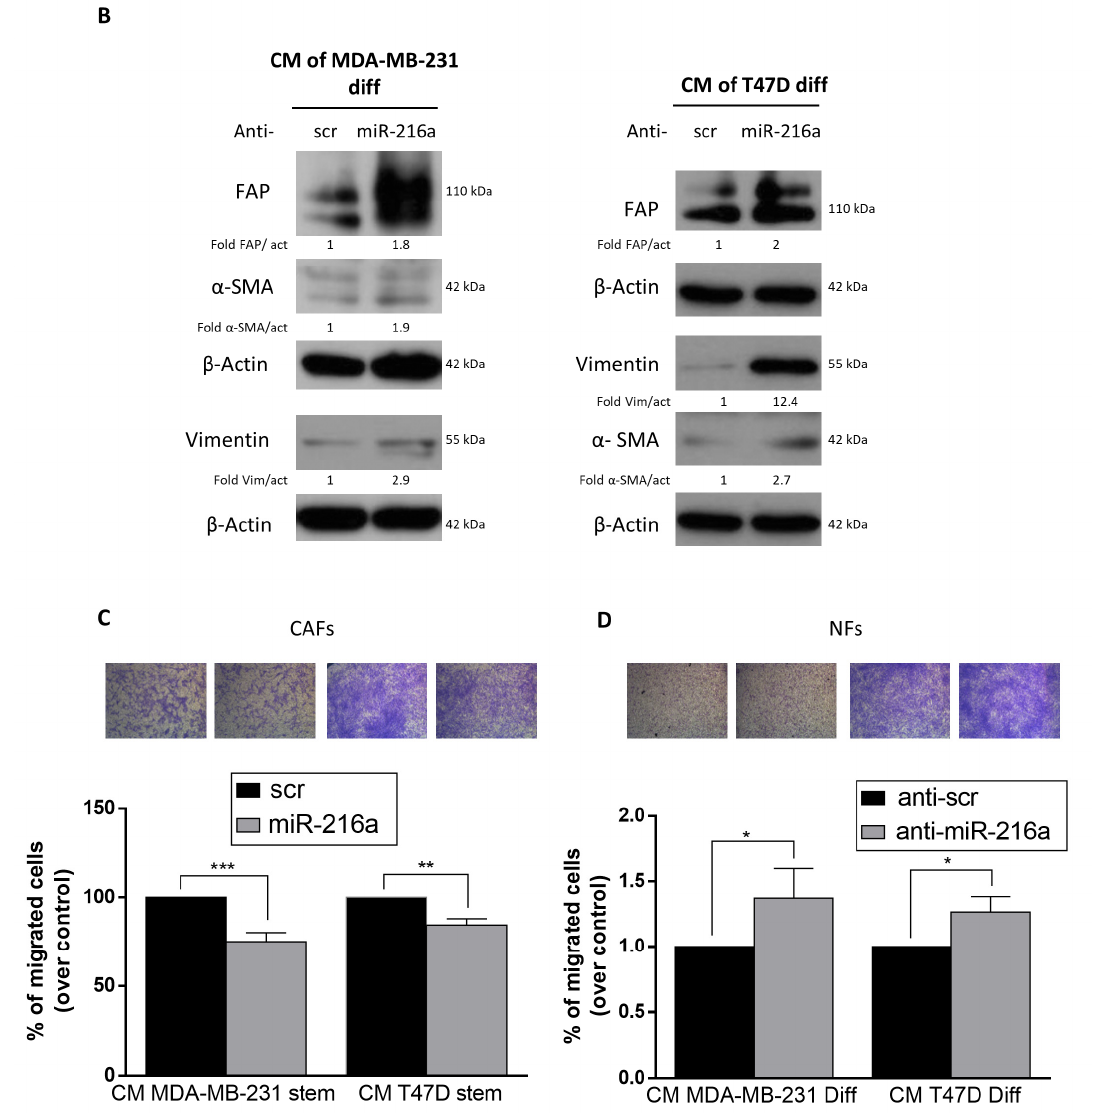
Figure 5. E ff ect of MiR-216a on cancer-associated fibroblasts (CAFs) and normal fibroblasts (NFs). ( A ) CAFs were treated with conditioned media collected from MDA-MB-231 and T47D stem cells overexpressing miR-216a. MiR-216a reduces CAF activation compared to the negative control. ( B ) Di ff erentiated MDA-MB-231 and T47D cells transfected with anti-miR-216a upregulates CAF markers in NFs. ( C ) CAFs treated with conditioned media collected from MDA-MB-231 and T47D stem cells transfected with miR-216a. MiR-216a impaired fibroblast migration compared to the negative control. Images were taken at 5 × magnification. ( D ) NFs treated with conditioned media collected from MDA-MB-231 and T47D di ff erentiated cells transfected with anti-miR-216a. Anti-MiR-216a sequence induces migration of cells compared to the negative control. Images were taken at 5 × magnification. Data are mean values ± SD of three independent experiments. Significance was calculated using Student’s t-test. *, p < 0.05; **, p < 0.01. ***, p <